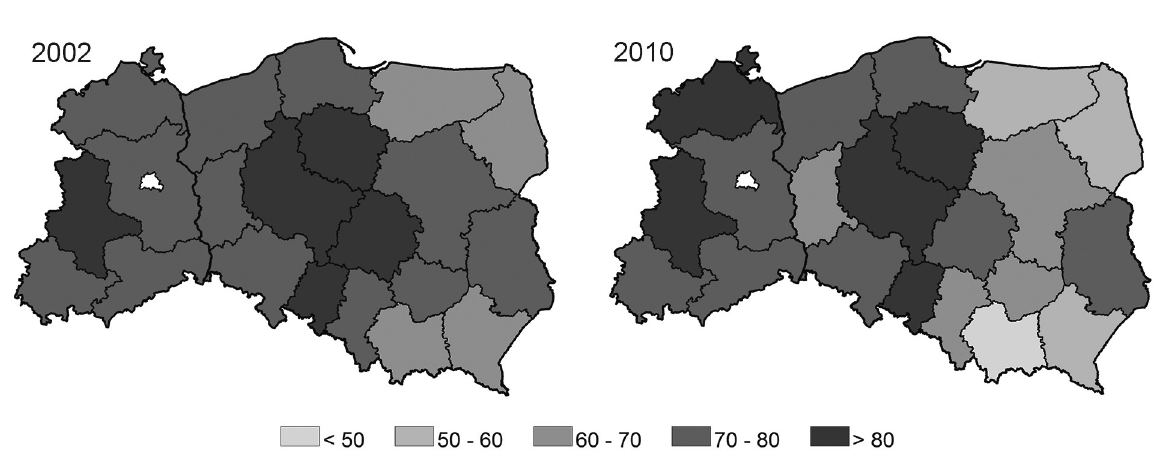
Fig. 2. Share of arable land in the total area in voivodeships in Poland and Länder in East Germany in 2002 and 2010 (%) Source: authors’ own calculation based on German 2011 data and Polish 2002 and 2010 Agricultural